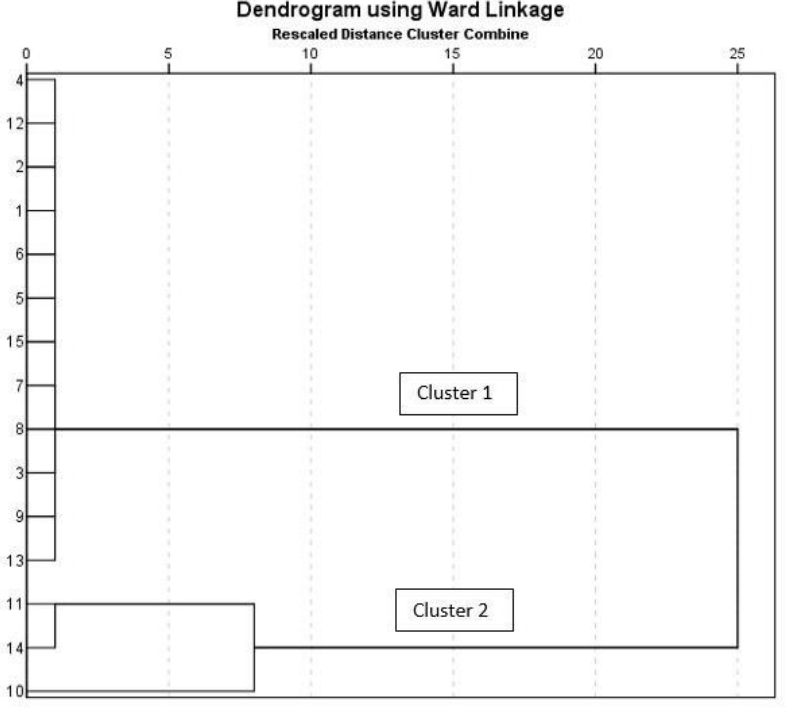
Figure 6. Classification of the sampling stations based on HCA outputs.